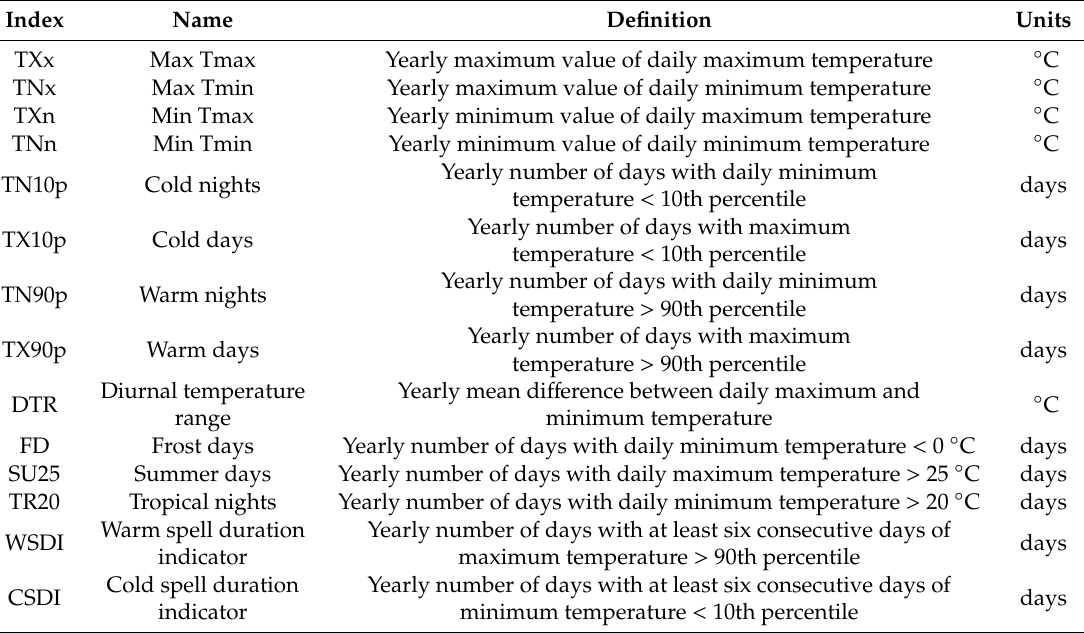
Table 3. Extreme temperature indices recommended by the Expert Team on Climate Change Detection and Indices (ETCCDI) used in this